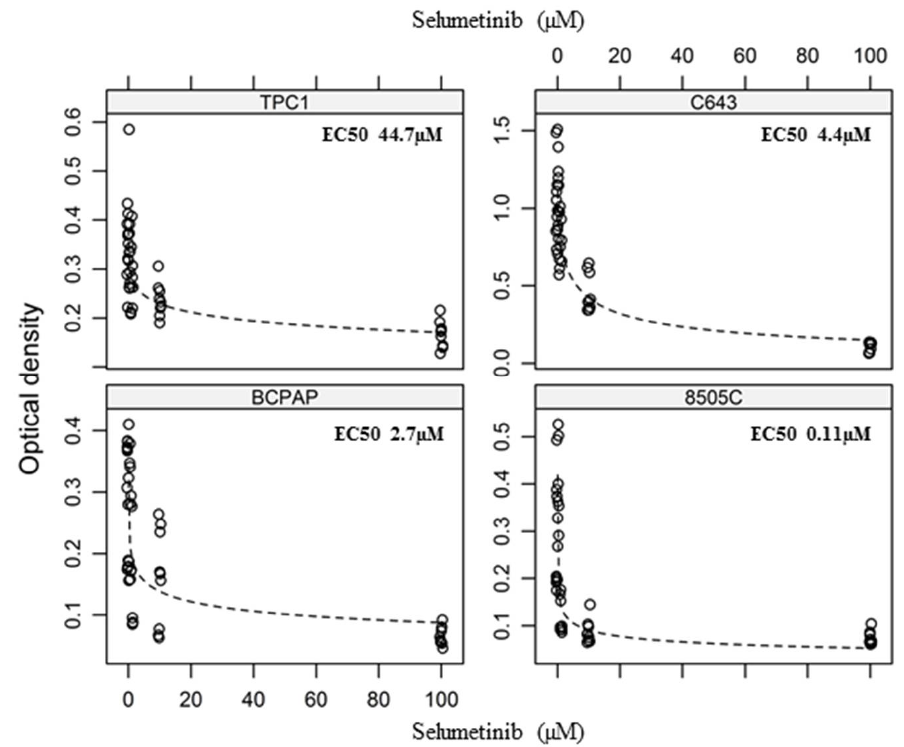
Figure 2. Dose-response to selumetinib. Curves of the four cell lines treated with increasing concentration of selumetinib for 144 h. Results of three independent experiments performed in triplicates (detailed data c.f. Table 1). p < 0.05 compared to control (detailed p -values c.f. Table 1). Table 1. p -Values showing that selumetinib treatment was significant at all concentrations for all four cells lines even for the lowest used concentration. p < 0.05 regarded as significant.